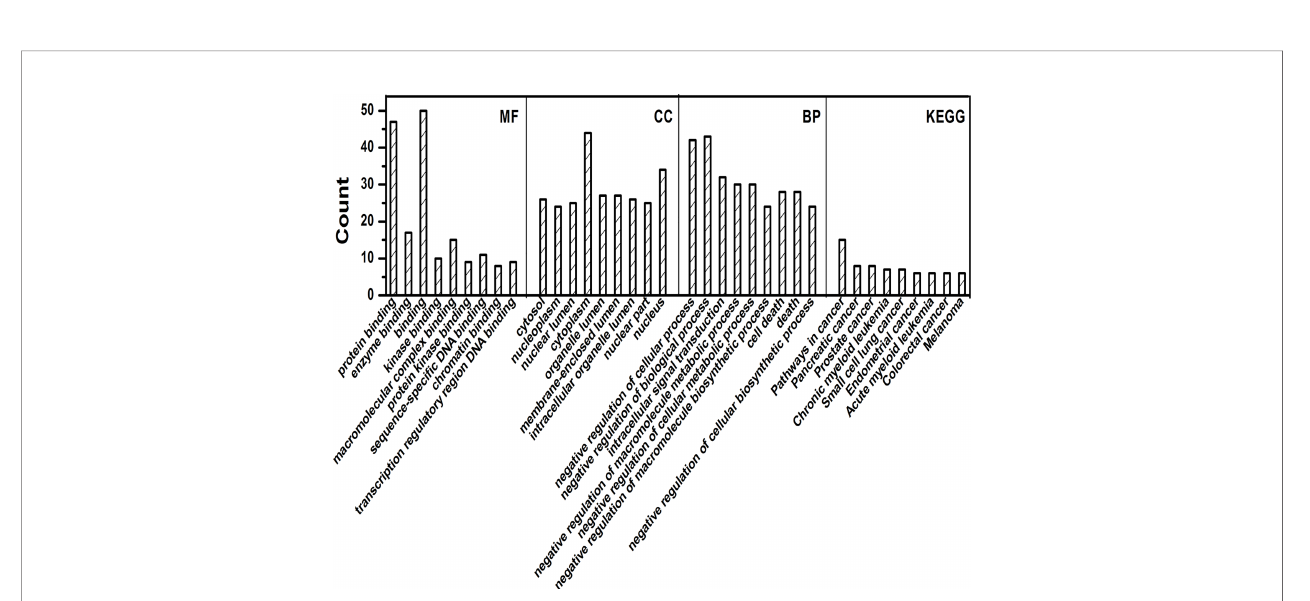
FIGURE 4 | GO and KEGG analysis by R package cluster Pro fi ler. Enrichment analysis of Gene Ontology for targeted genes that include biological processes (BP), molecular function (MF), and cell fractions (CC) as well as KEGG pathways analysis.